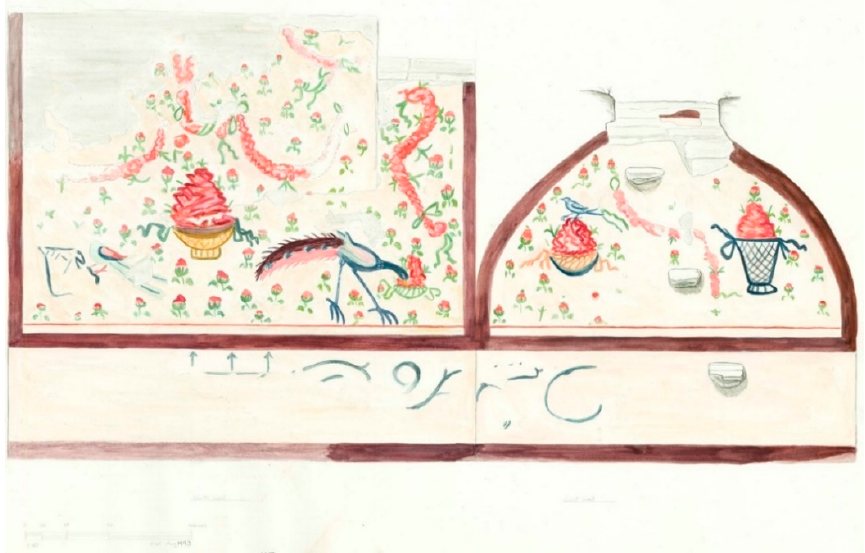
Figure A4. Sardis, Tomb 93.1 (Appendix A.4), painting of north and east walls. © Archaeological Exploration of Sardis/President and fellows of Harvard College.